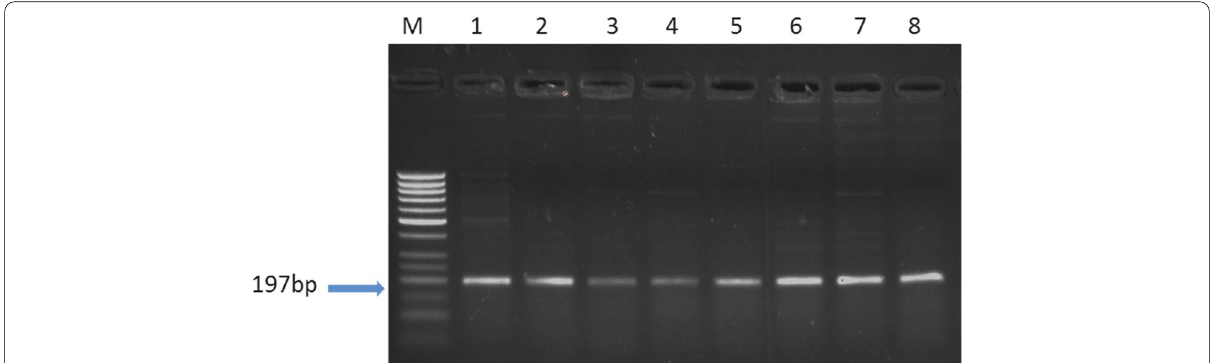
Fig. 4 PCR product of LEPR gene, M: 50bp ladder, lanes 1–8: fertile and repeat breeder buffaloes